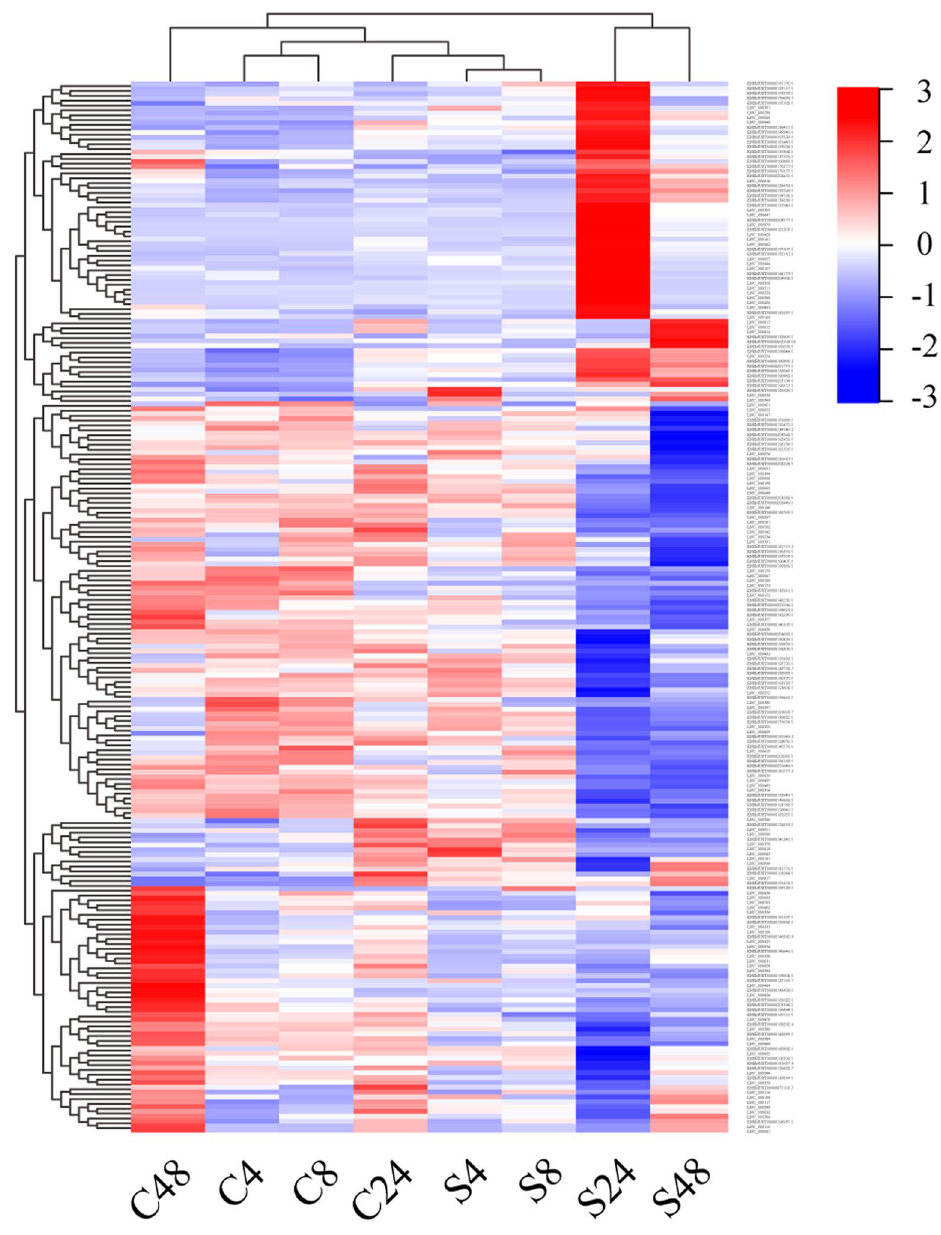
Figure 1. Hierarchical heat map of differential lncRNA expression induced by Brucella infection in RAW264.7 cells by RNA-Seq analysis. A hierarchical cluster heat map exhibiting RNA-Seq based differential expression of lncRNAs in RAW264.7 cells with a Brucella abortus S2308 infection for 4, 8, 24 and 48 h was generated by using the Pretty heatmaps (https:// github. com/ raivo kolde/ pheat map). Both the red and blue colors represent higher and lower expression of lncRNA genes by log10 transformed expression values, respectively. S4, S8, S24 and S48 represent an S2308 infection for 4, 8, 24 and 48 h, respectively, while C4, C8, C24 and C48 represent mock infection for 4, 8, 24 and 48